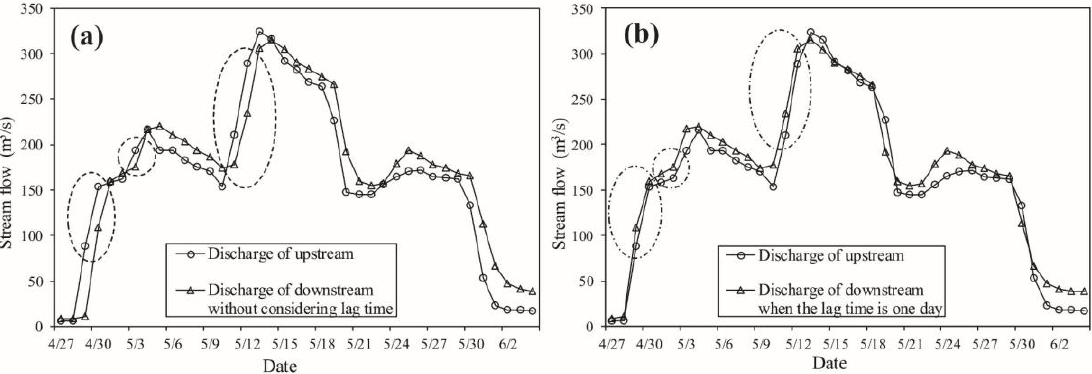
Figure 4. The changes in upstream and downstream flow during April 27–June 4. ( a ) Without considering lag time, ( b ) considering the lag time of one